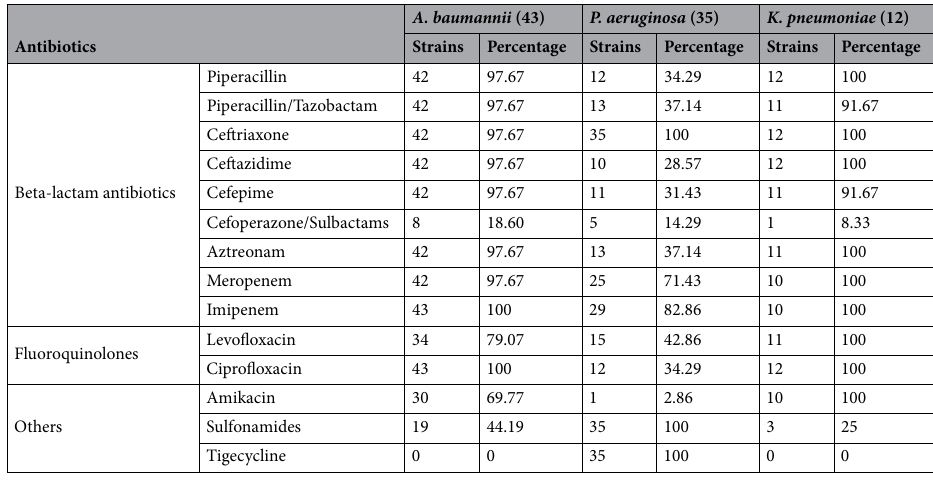
Table 3. Antibiotic resistance results of gram-negative MDRO strains in patients with